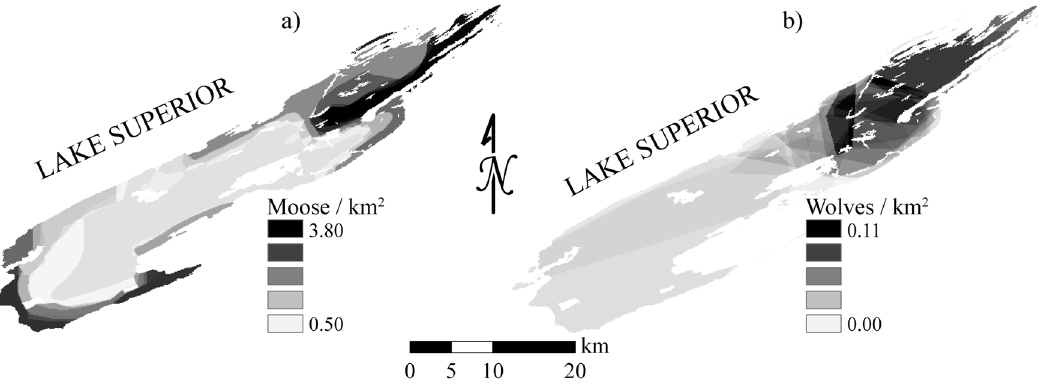
Figure 4. The spatial distribution for a) moose and b) wolves in Isle Royale National Park, Lake Superior, USA. These distributions were documented each year via aerial surveys (e.g., Vucetich and Peterson [43]). Each panel show the means population density, averaged across each year of the study period, 2000–2008.